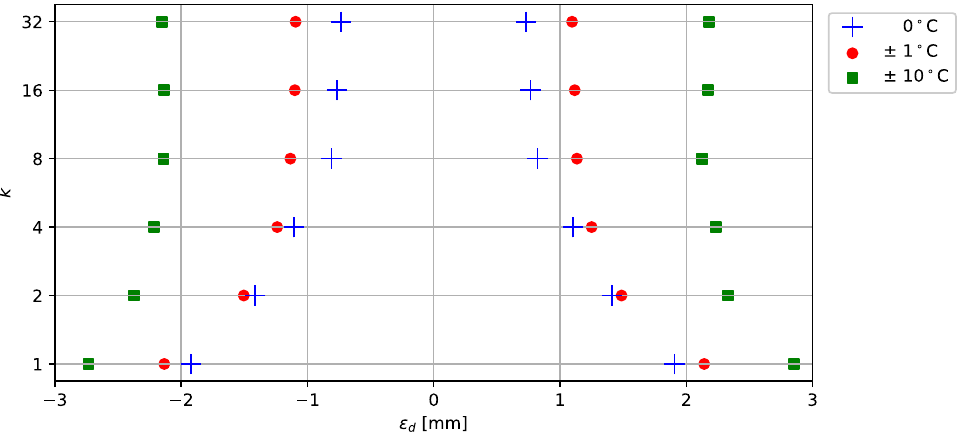
Figure 13. Deformation error ( (cid:101) d ) in function of number of averaged measurements ( k ) expressed as 2.5th and 97.5th percentiles for 0 ◦ C, ± 1 ◦ C and ± 10 ◦ C temperature